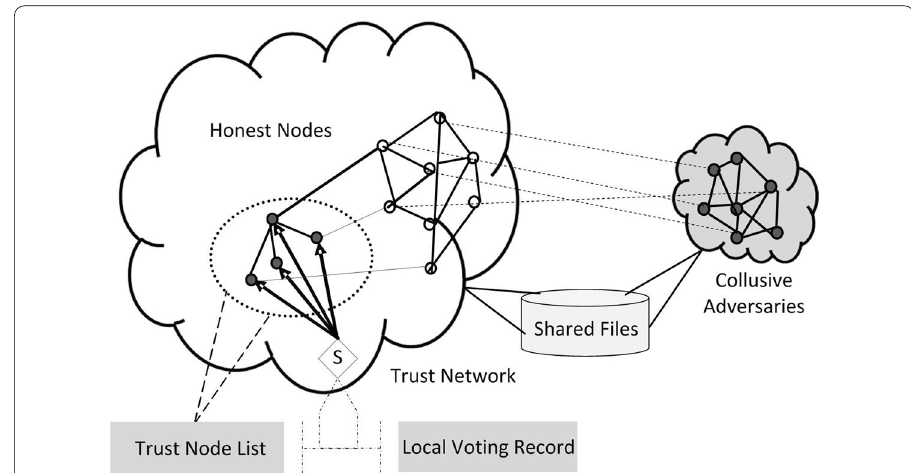
Fig. 1 Network model of the service rating system. As an independent object evaluation model, the evaluation system has nothing to do with the specific structure of the distributed network. As shown in figure, all nodes, including honest users and adversaries, provide collaborative services. Honest users cooperate with the network to publish and retrieve the service content of interest and always ensure that accurate service content is provided. Competitor nodes try to provide fake services and improve their visibility. Without a special content rating and evaluation system, users cannot accurately distinguish between true and false results. Our reputation evaluation system uses the network user group to score the services used. Any user in the system has a unique identity and can make his own evaluation on the services in the